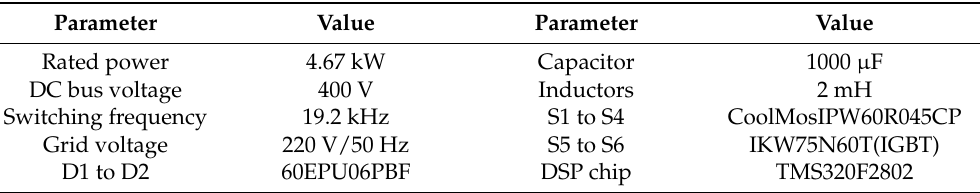
Figure 19. Terminal voltage of switches and inductor current MMI.